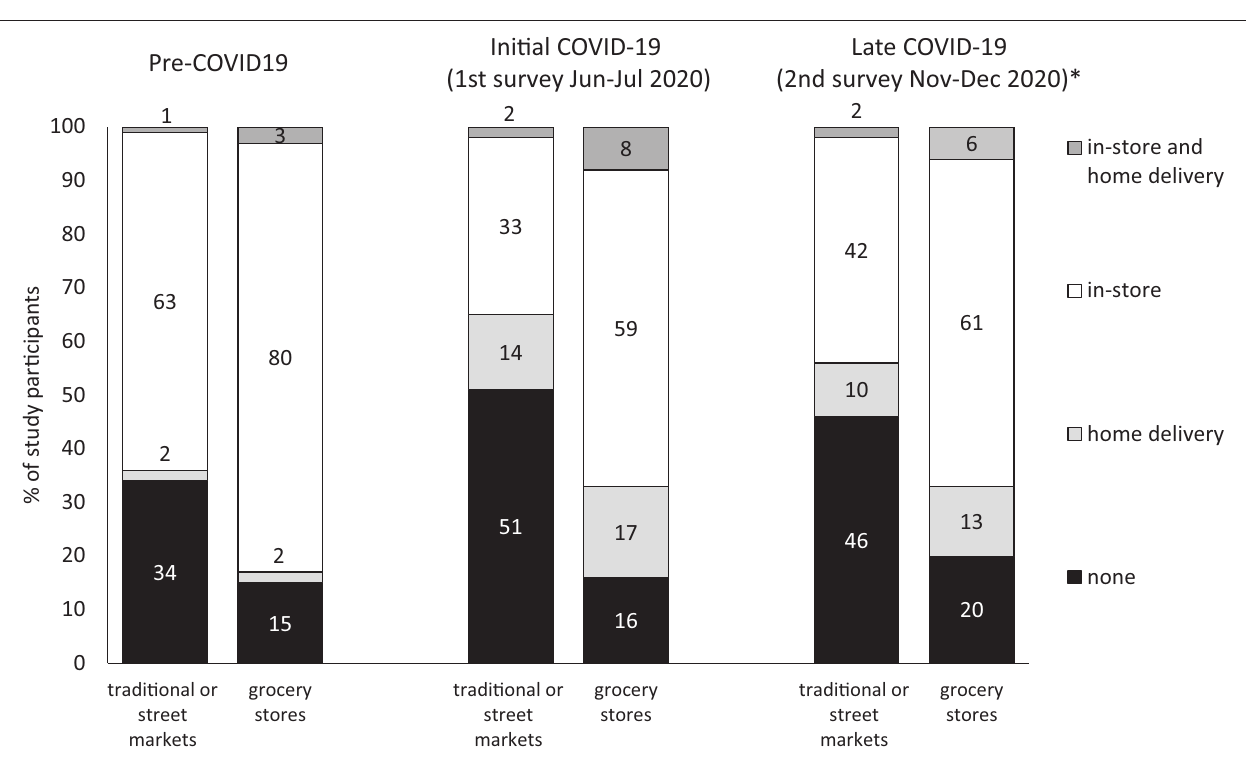
people, while stockpiling junk food was more frequent among those with low SES ( Table 3